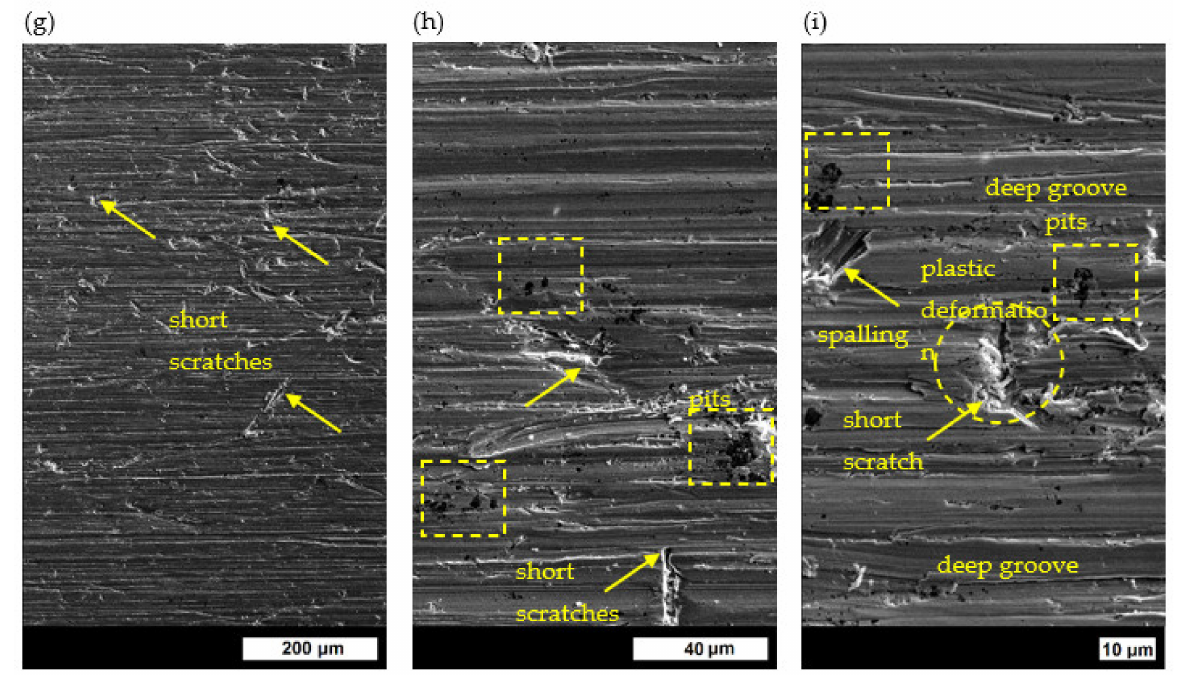
Figure 14. Wear surface of ingot No. 1 after quenching and tempering: ( a ) at 200 ◦ C, 600 × ; ( b ) at 200 ◦ C, 3000 × ; ( c ) at 200 ◦ C, 5000 × ; ( d ) at 400 ◦ C, 600 × ; ( e ) at 400 ◦ C, 3000 × ; ( f ) at 400 ◦ C, 5000 × ; ( g ) at 600 ◦ C, 600 × ; ( h ) at 600 ◦ C, 3000 × ; ( i ) at 600 ◦ C, 5000 × . Unetched,